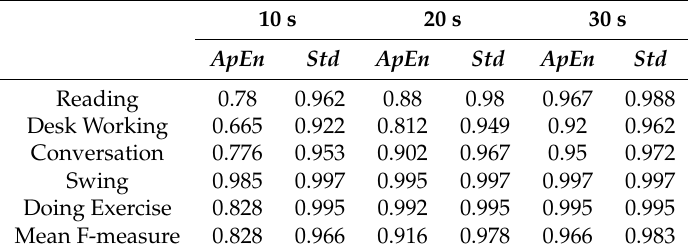
Figure 5. Activity recognition results with different time slide window. Table 6. F-measure for each activity with different time window.